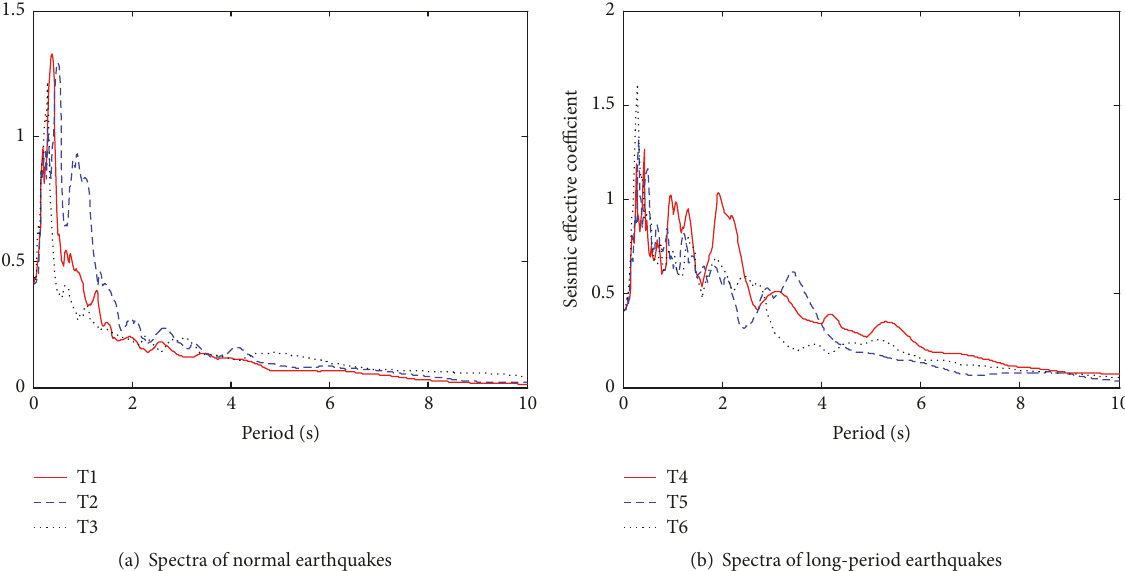
Figure 20: Acceleration response spectra.